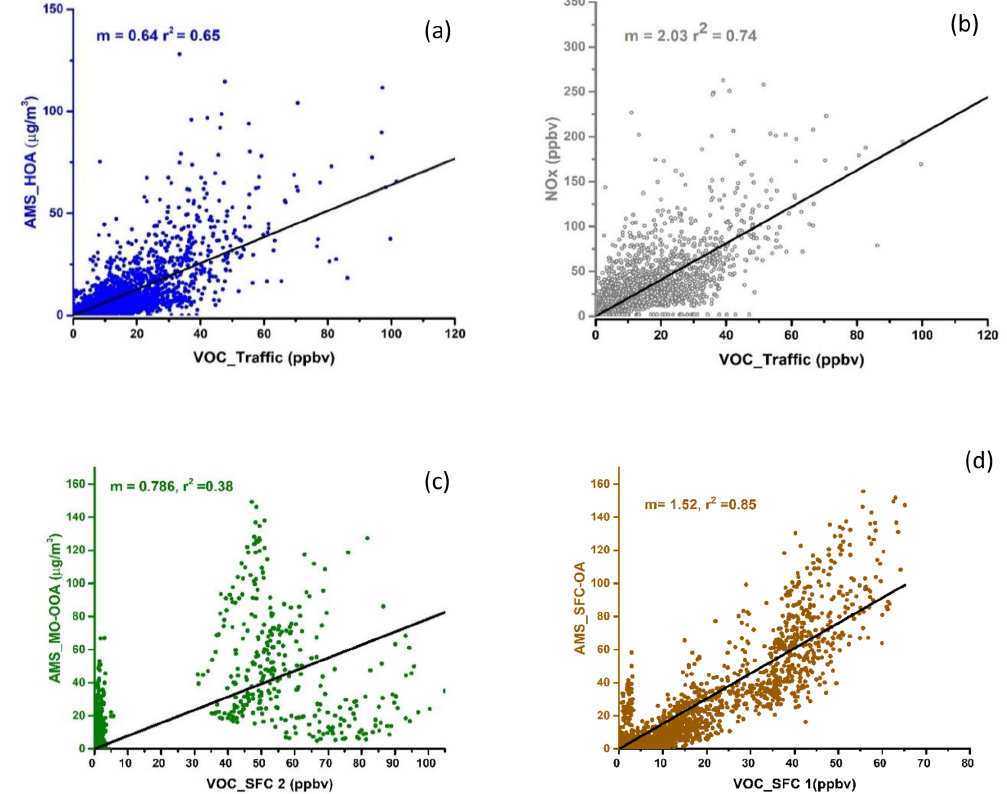
Figure 9. Scatter plots showing a correlation between VOC_factors with their respective AMS_factors.